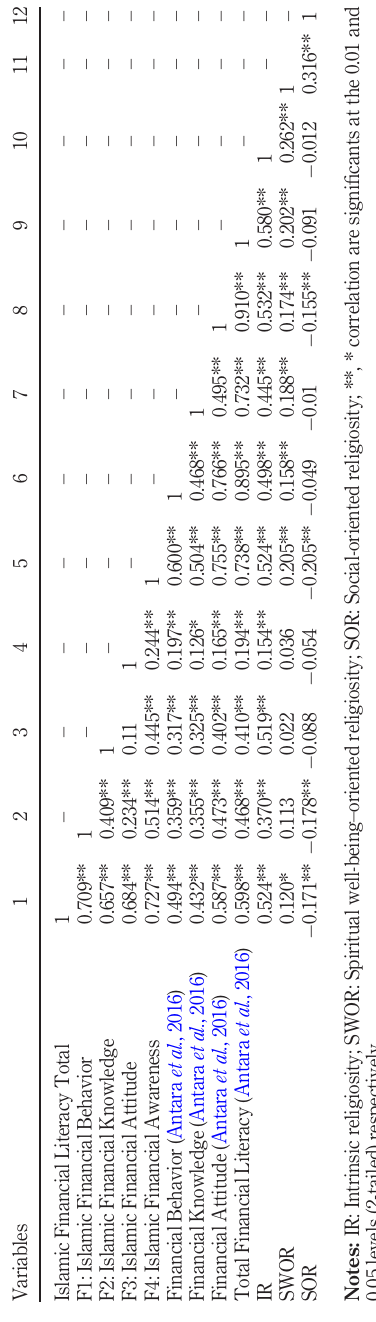
Table 4. Correlation